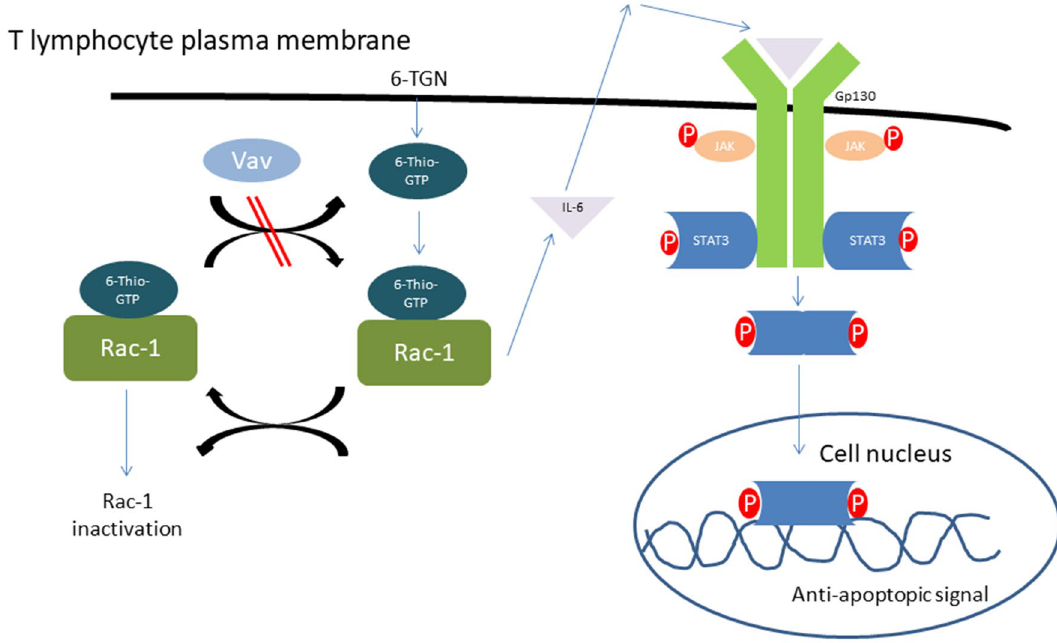
Figure 2. A simplified scheme of the Rac1/pSTAT3 pathway. 6-TGN 6-thioguanine nucleotides, 6-TGTP 6-thioguanine triphosphate, gp130 G-protein 130, IL-6 Interleukine-6, JAK Janus Kinase, Rac-1 Ras-related C3 botulinum toxin substrate-1, STAT3 Signal transducer and activator of transcription 3, Vav guanine nucleotide exchange